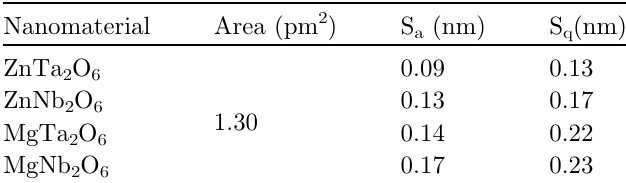
and S for the measured areas a q